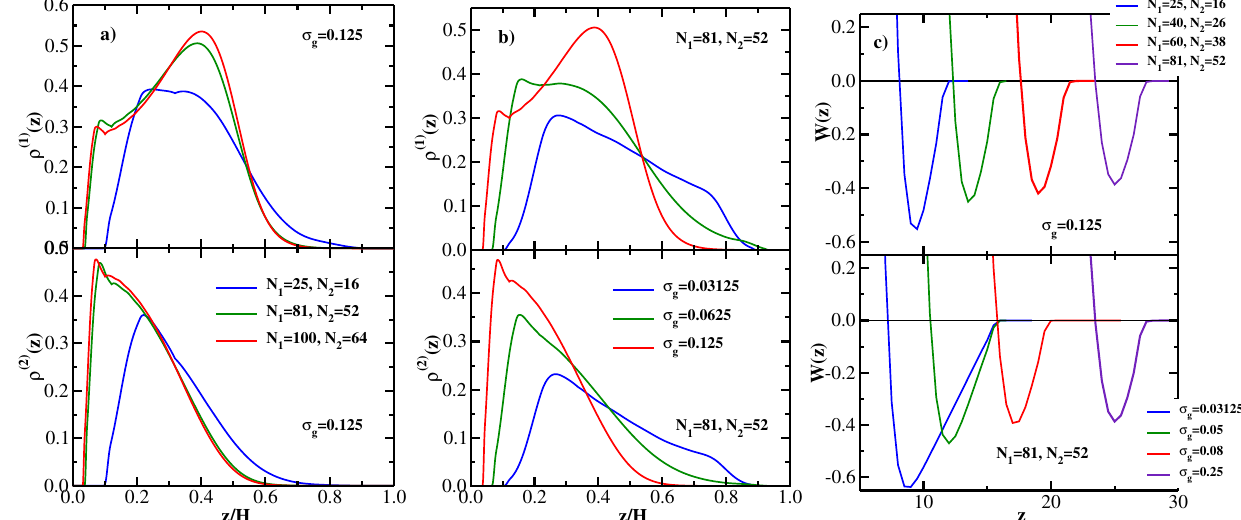
Figure 5. ( a ) Upper panel: DFT results for the equilibrium monomer density distributions for equimolar bidisperse flexible brushes at equilibrium separation H vs z / H ; grafting density is σ g = 0.125 and three pairs of grafted chain lengths are considered: ( N 1 = 25, N 2 = 16), ( N 1 = 81, N 2 = 52), and ( N 1 = 100, N 2 = 64). Only monomer density distributions of the longer chains (length N 1 ) grafted at the left wall are shown; the distributions of the chains grafted at the right wall are mirror-symmetric (around the mid-point of the gap between the walls) with respect to the left-wall grafted chains. Lower panel: same as the upper panel but for the shorter grafted chains (length N 2 ). ( b ) Upper panel: DFT results for the equilibrium monomer density distributions for equimolar bidisperse flexible brushes at equilibrium separation H vs z / H ; grafted chain lengths are ( N 1 = 81, N 2 = 52) and three values of the grafting density are considered: σ g = 0.03125, σ g = 0.0625, and σ g = 0.125. Lower panel: same as the upper panel but for the shorter grafted chains (length N 2 ). ( c ) Upper panel: PMF between two equimolar bidisperse flexible brushes as a function of wall-wall separation at the grafting density σ g = 0.125 for four pairs of the grafted chain lengths ( N 1 , N 2 ), as indicated. Lower panel: PMF between two equimolar bidisperse flexible brushes as a function of wall-wall separation for the grafted chain lengths ( N 1 = 81, N 2 = 52) for four values of the grafting density σ g , as